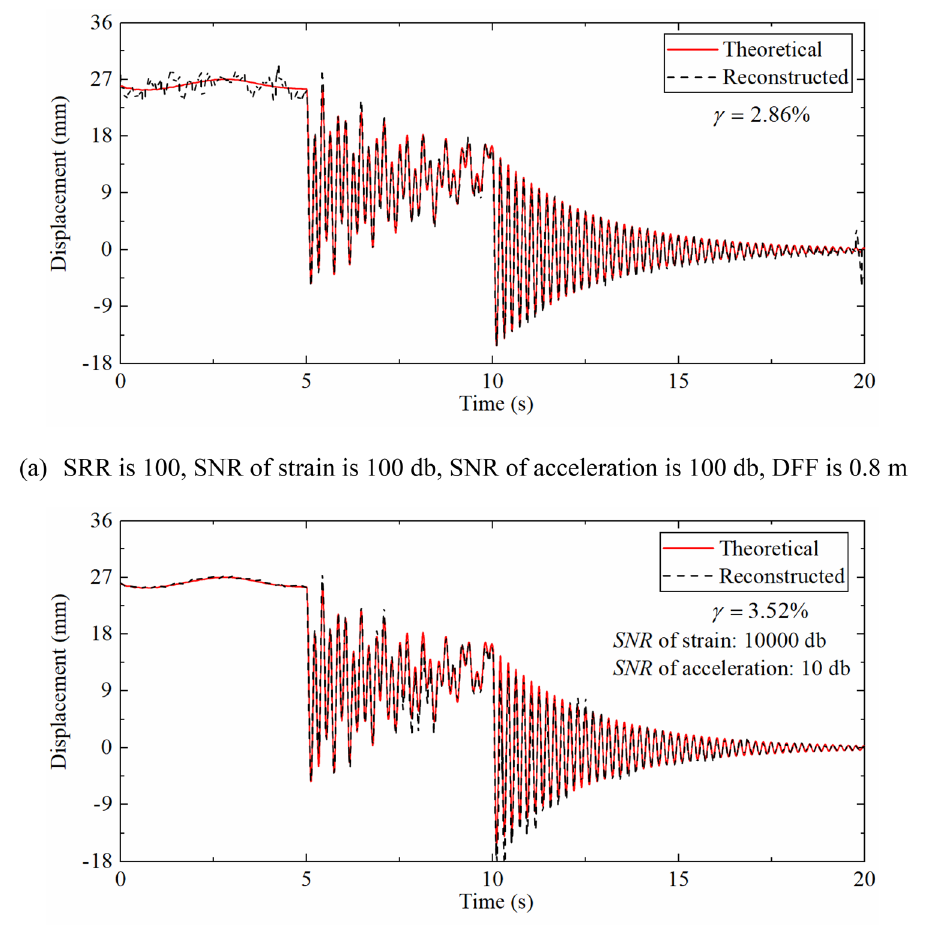
Figure 8. Displacement time history